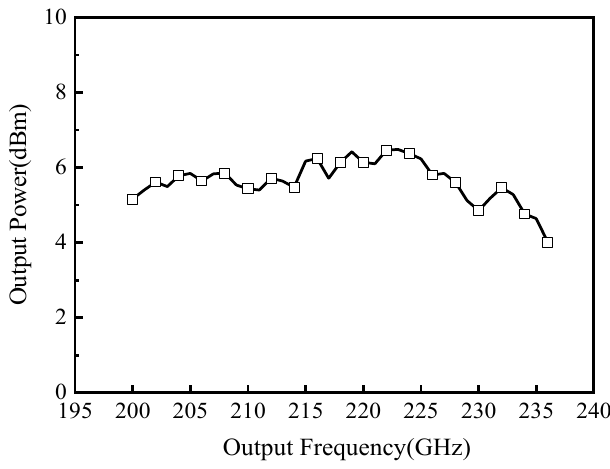
Figure 20. Output power of the 220 GHz transmitter.